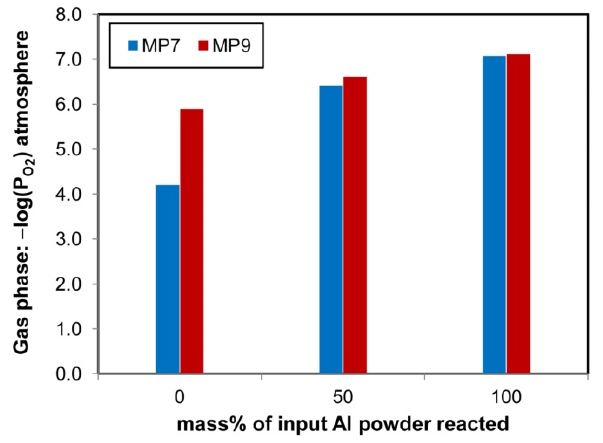
Figure 10. Calculated gas phase partial oxygen pressure according to gas ‐ slag ‐ metal powder equi ‐ librium at 2500 °C: MP7 to MP9 comparison.